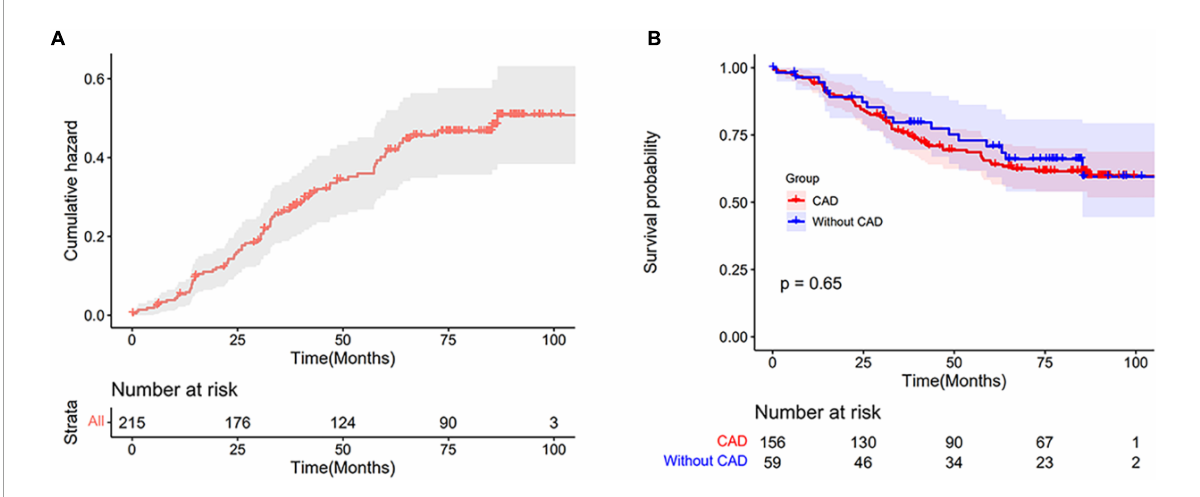
FIGURE3 (A) The cumulative hazard curve of patients with PH-LHF. (B) Kaplan-Meier estimates of survival in PH-LHF patients with CAD and without